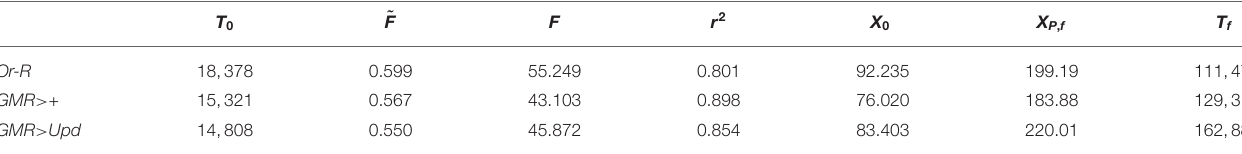
TABLE 1 | Results of the adjustment of the geometric model presented in this article to the experimental results on the Drosophila melanogaster strains Oregon-R ( Or-R ), GMR-GAL4 ( GMR > + ) and GMR-GAL4;UAS-Upd ( GMR > Upd ) from Vollmer et al. (2017b).